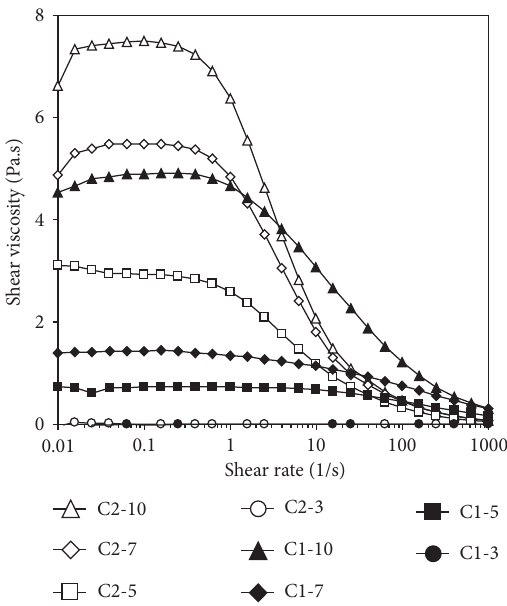
Figure 3: Shear viscosity of the chitin solutions prepared at dif- ferent LiCl concentrations.